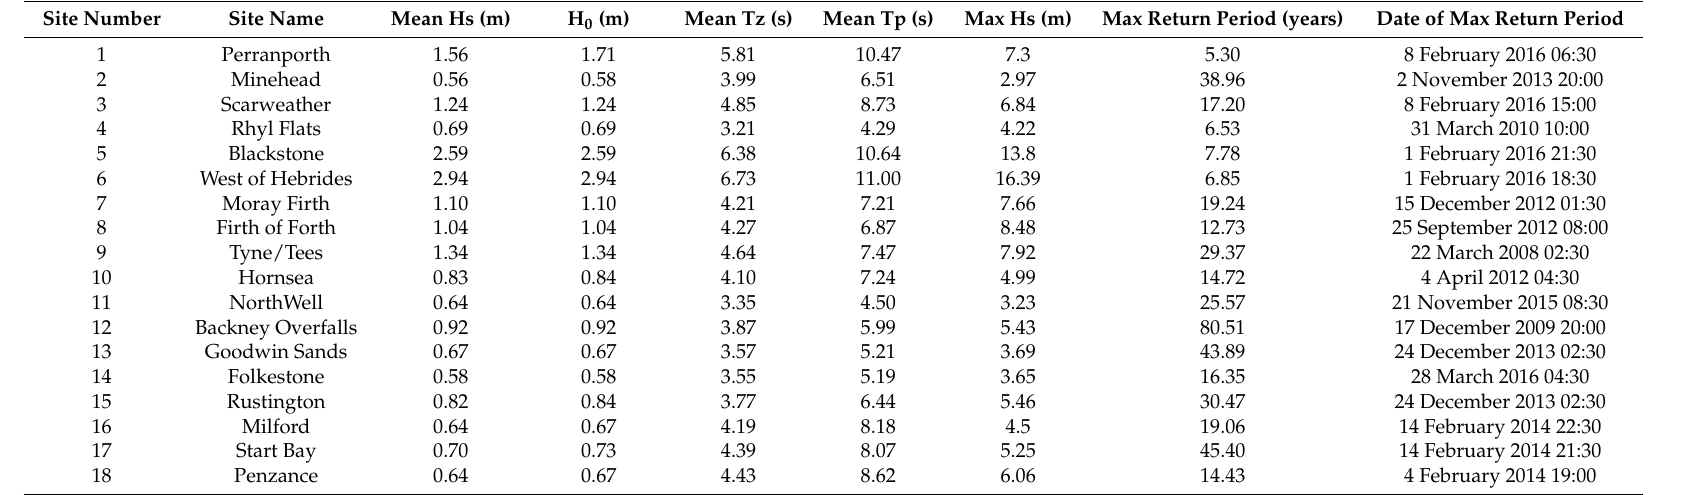
Table 4. Name, location, and wave variable characteristics for each of the